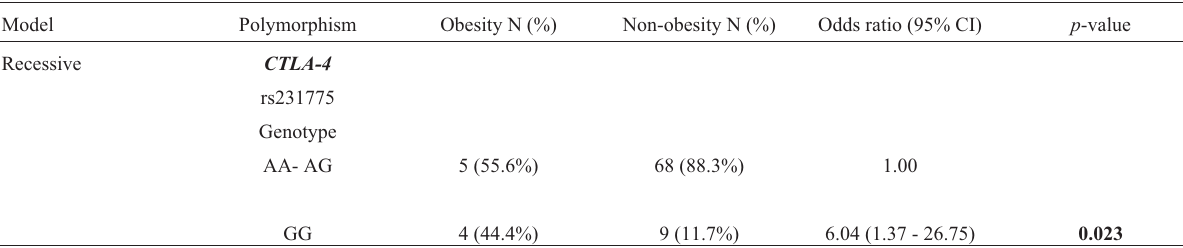
Table 3 - Genotype distribution of CTLA-4 gene polymorphisms in TS